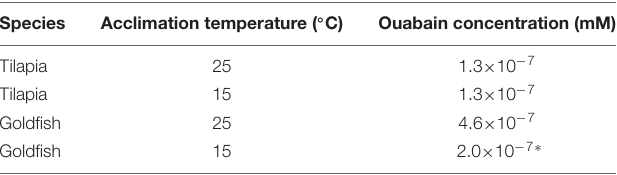
TABLE 3 | Inhibitory concentrations of Ouabain (IC 50 ) for Na + /K + -ATPase activity in tilapia and goldfish gill after cold acclimation. Species